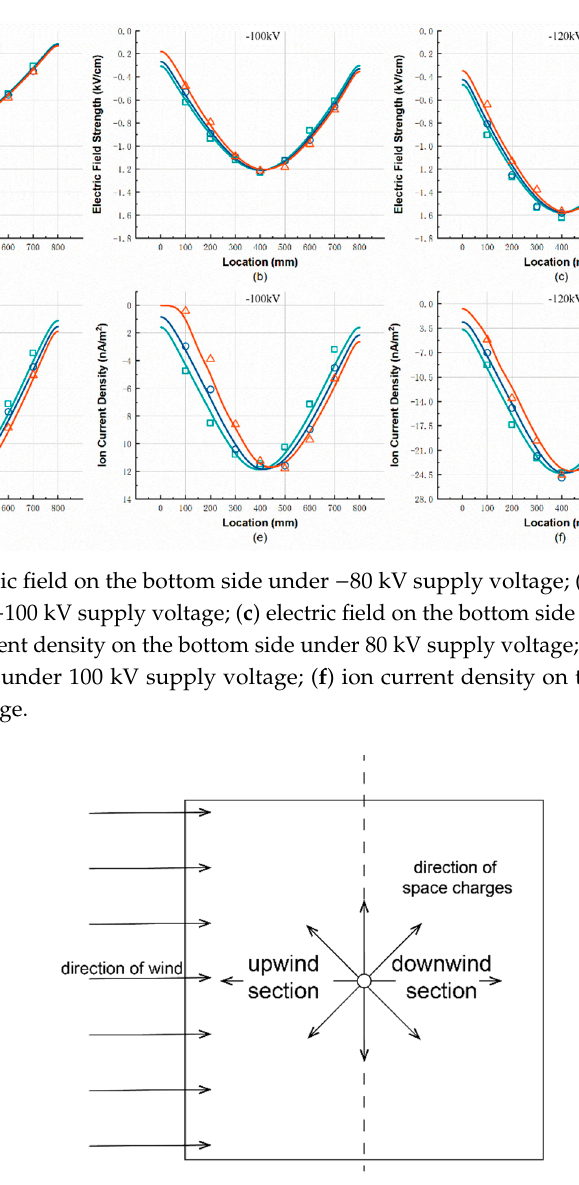
Figure 11. Schematic diagram of the cross-section.